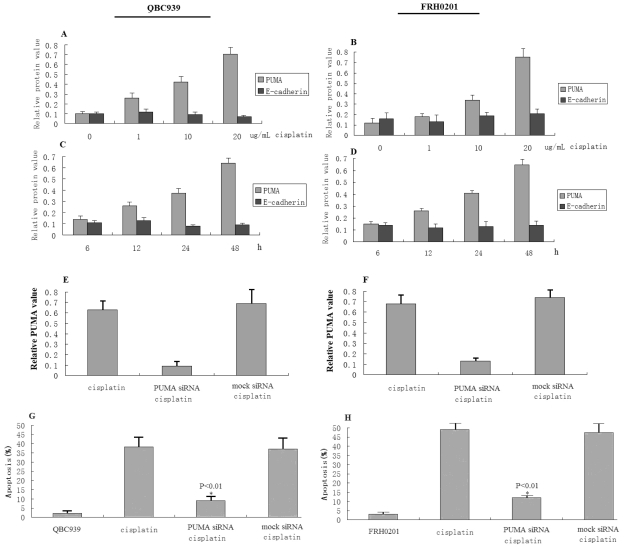
Induction of apoptosis by cisplatin is independent of PUMA mechanism. (A, B) The QBC939 and FRH 0201 cells were exposed to various cisplatin concentrations for 72 h. The PUMA and E-cadherin protein expression levels in the cell lysate were examined by Western blot analysis using anti-PUMA (E-cadherin) antibody, and the antibodies against ß-actin which served as an internal control. (C, D) The QBC939 and FRH 0201 cells were exposed to 20 μg/mL cisplatin for the indicated times. The PUMA and E-cadherin protein expression level was measured by Western blot. (E, F) QBC939 and FRH0201 cells (1 × 106/mL) were exposed to 20 μg/mL cisplatin combined with PUMA siRNA for 72 h, PUMA protein expression level was measured by Western blot. (G, H) QBC939 and FRH0201 cells (1 × 106/mL) were exposed to 20 μg/mL cisplatin combined with PUMA siRNA for 72 h, after which time the percentage of apoptotic cells was determined by flow cytometric analysis, as described in “Materials and Methods”. Cisplatin combined with PUMA siRNA did not induce obvious apoptosis in QBC939 and FRH 0201 cells (*P < 0.01).